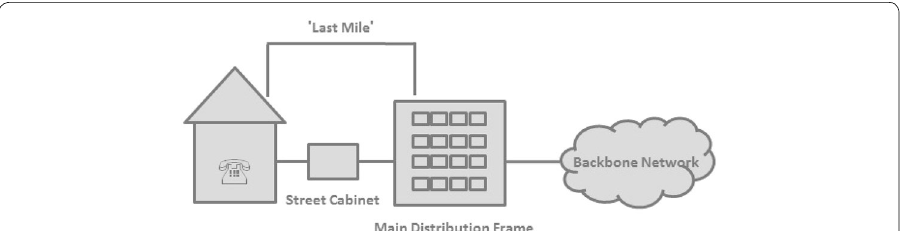
Fig. 1 The Structure of a DSL Network. The figure shows the structure of a DSL network that relies on the “last mile” of the preexisting fixed-line voice-telephony network. The “last mile” consists of copper wires connect- ing every household via the street cabinet to the main distribution frame (MDF). At the MDF, a DSLAM (Digital Subscriber Line Access Multiplexer) is installed that aggregates and redirects the voice and data traffic to the telecommunication operator’s backbone network. Source: Falck et al.